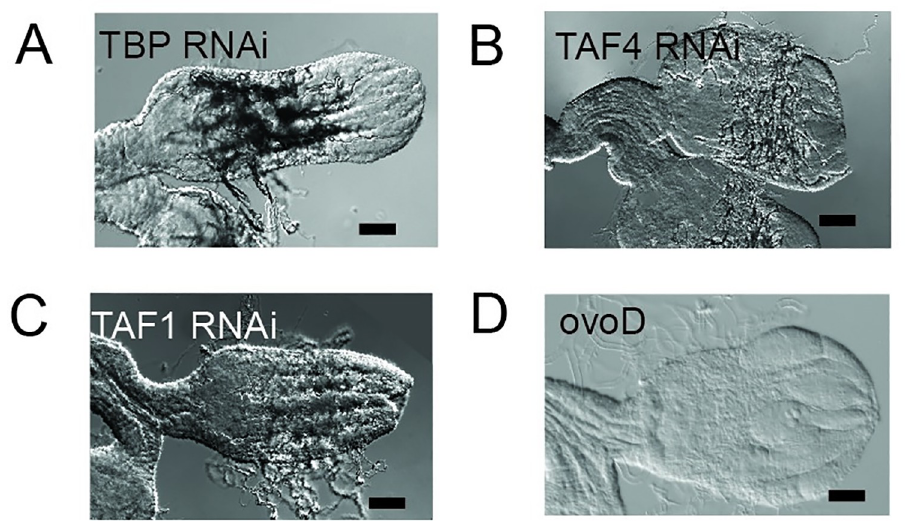
Fig 3. TFIID subunit depletion blocks oogenesis earlier than SAGA subunit depletion. (A) TBP RNAi ovary pair (B) TAF4 RNAi ovary pair. (C) TAF1 RNAi ovary pair. (D) OvoD control ovary pair. Scale bar: 50 uM.